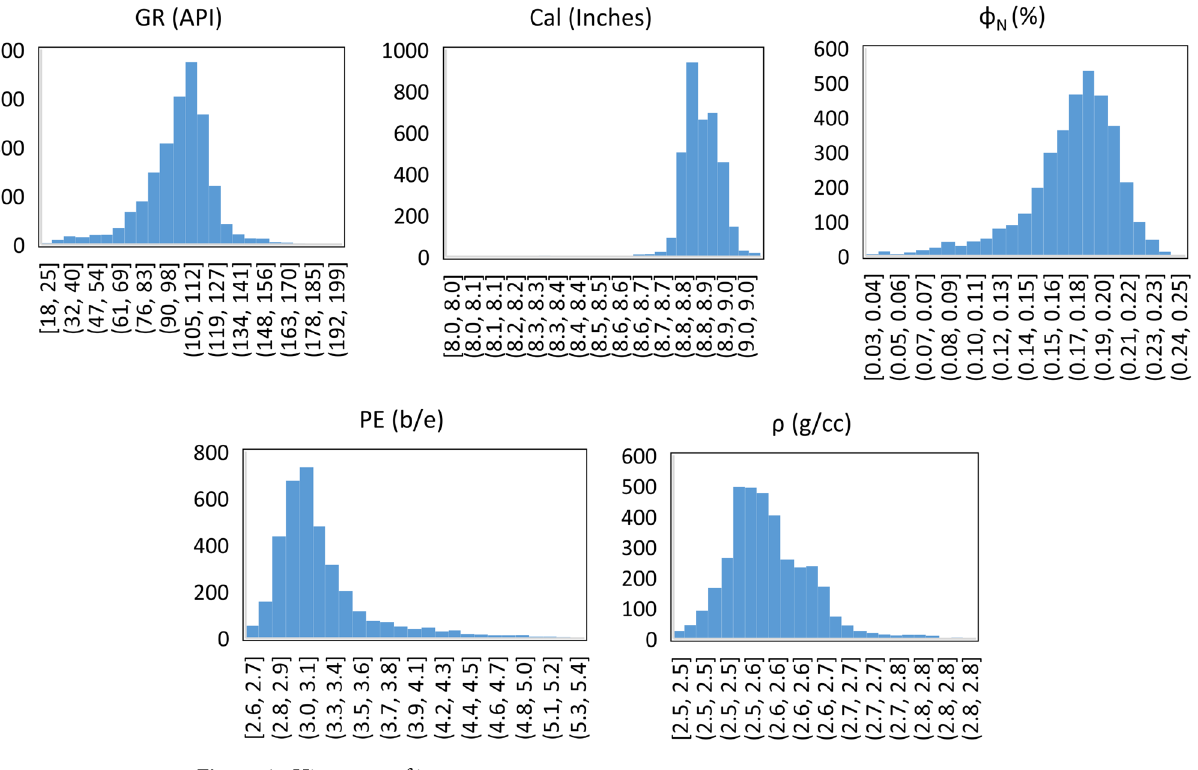
Figure 6. Histogram of input parameters.